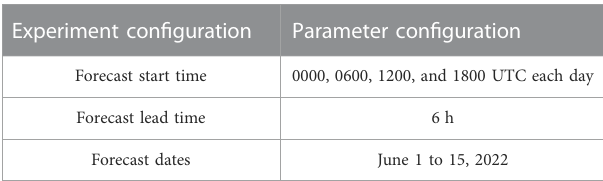
TABLE 2 Con fi guration of the analysis bias experiment. TABLE 3 Con fi guration of the analysis bias experiment.